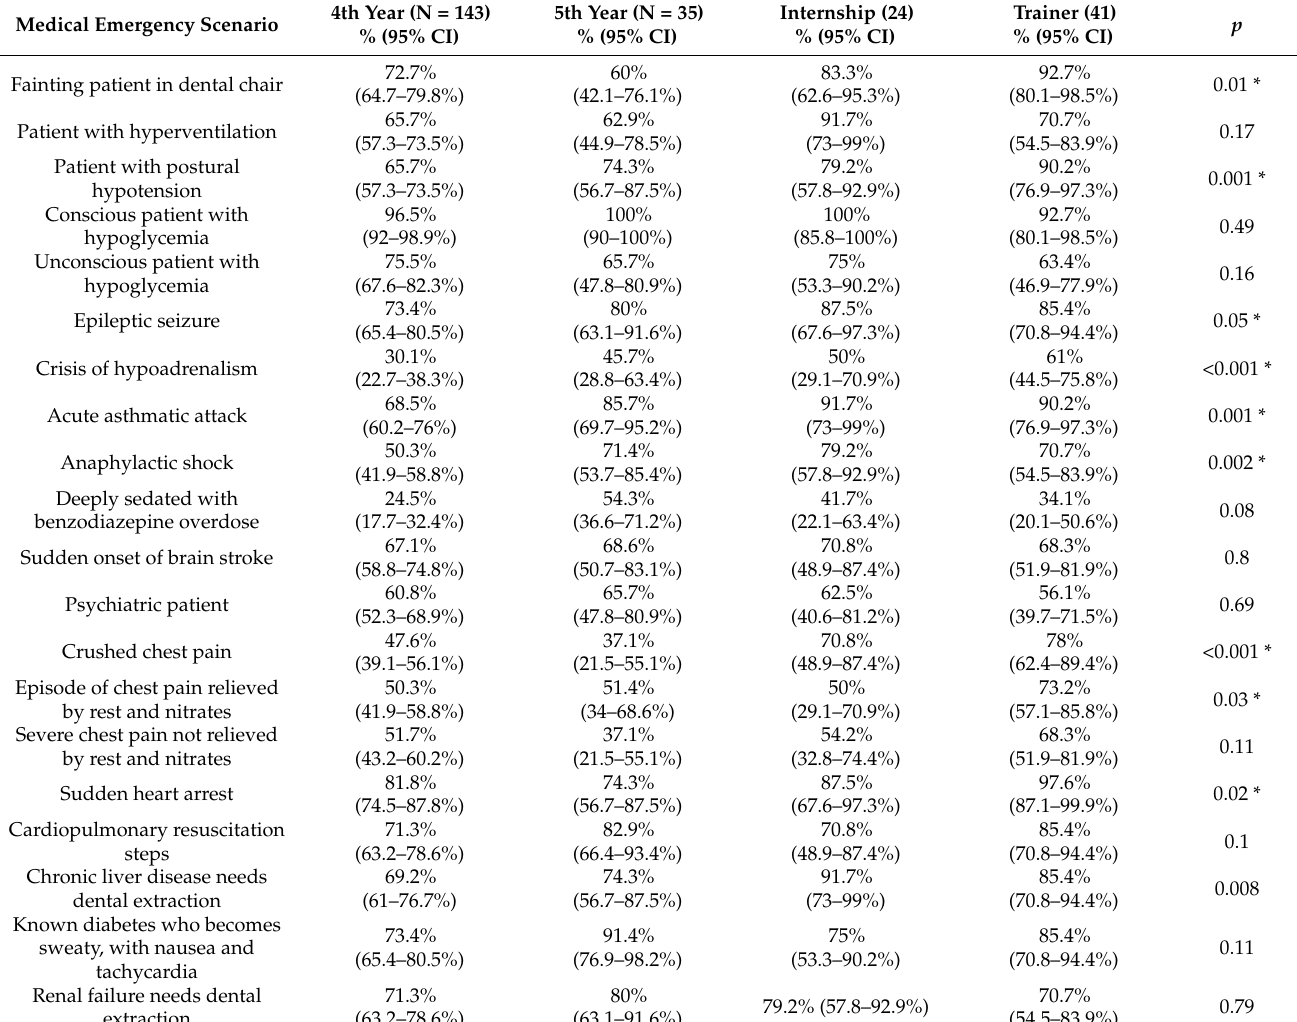
Table 3. Percentages of correct answers of participating dental students and clinical trainers to the management of 20 medical emergency cases that frequently take place in the dental